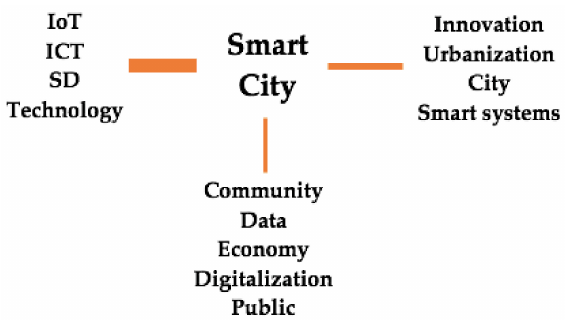
Figure 16. A comprehensive approach to the S.C. idea with the strength of the relationships between main